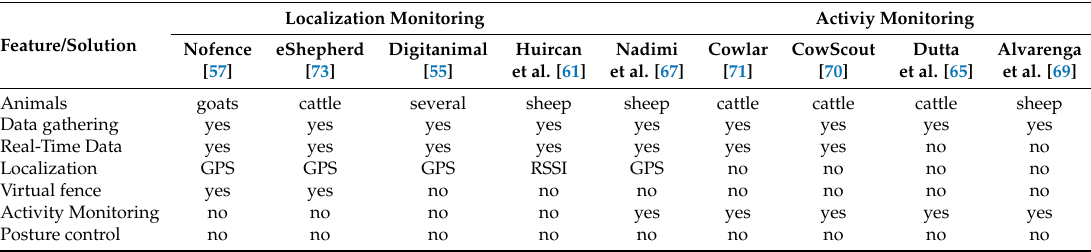
Table 1. Summary of the most relevant works and commercial platforms on animal monitoring.